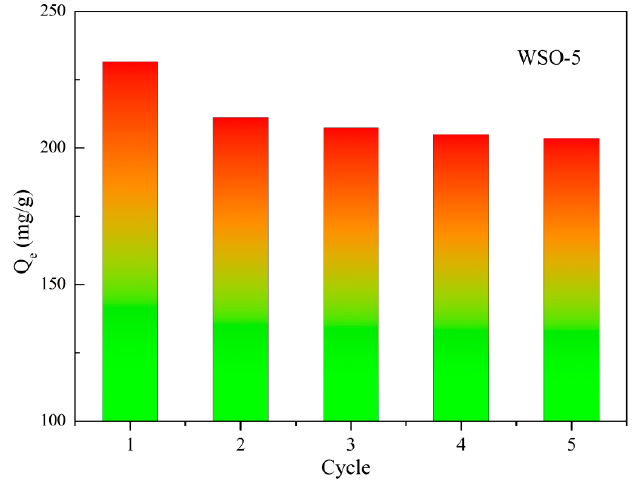
Figure 13. The recyclability of WSO ‐ 5.